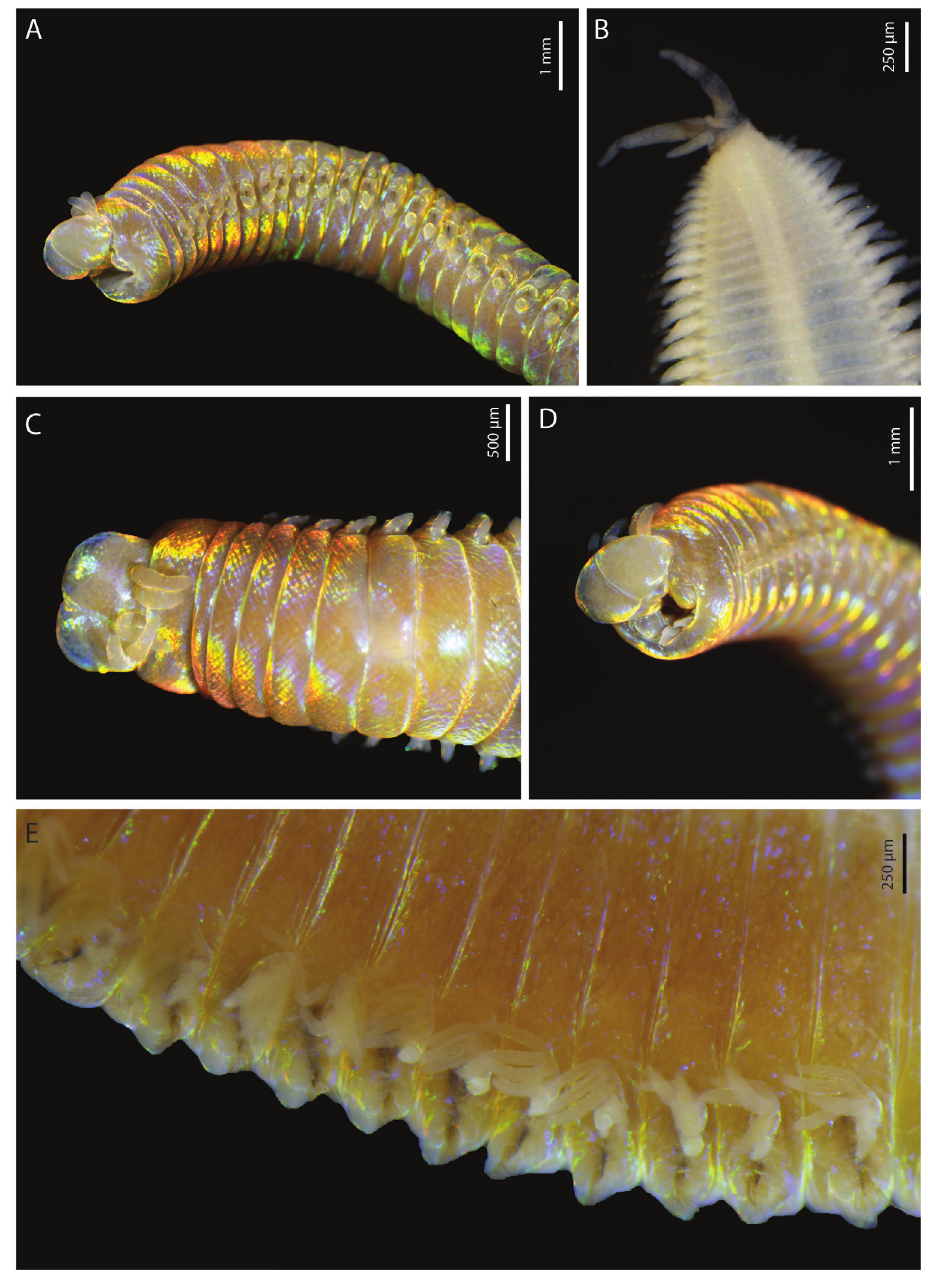
Figure 2. Marphysa banana sp. nov. holotype MNHN-IA-2015-1608 ( B ) paratype MNHN-IA-2021-725 ( A, C–E ): A anterior end, lateral view B pygidium, ventral view C anterior end, dorsal view D anterior end, frontal view E anterior chaetigers, dorso-lateral